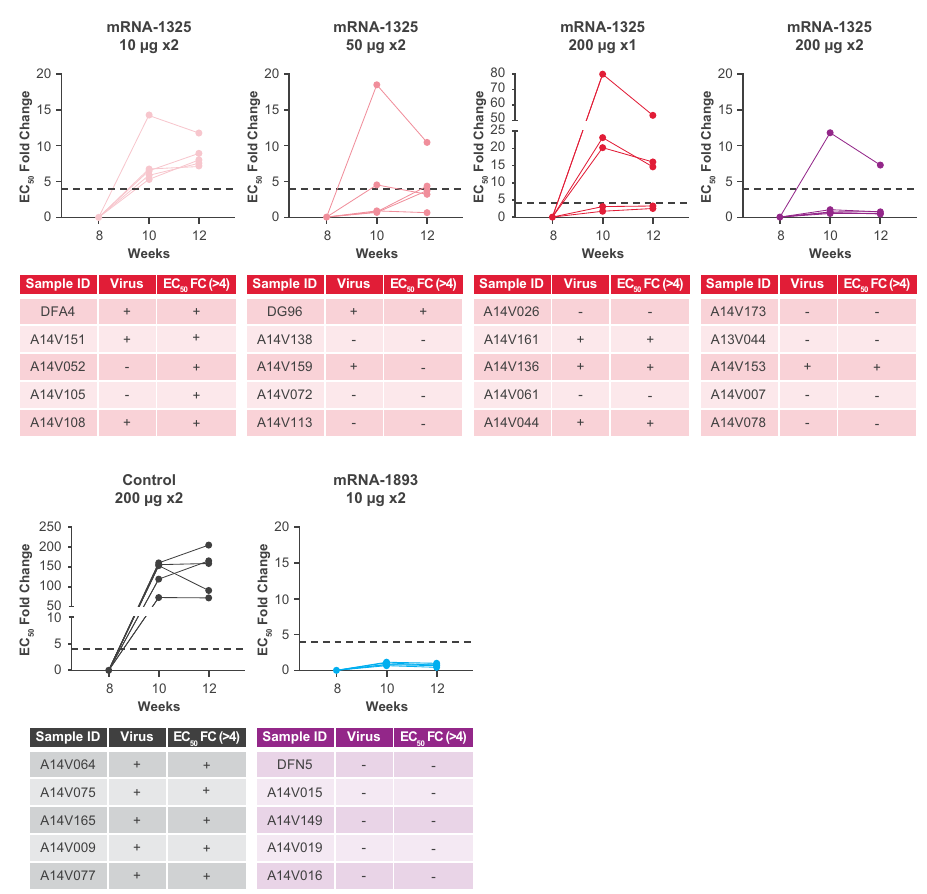
Fig. 5 nAb titers in NHPs immunized with mRNA-1893. Data are plotted as the EC 50 fold change relative to the time of challenge (week 8), which was set to 1. Tables below each graph indicate whether the virus was detected on any day following the challenge and if the EC 50 value had a 4-fold or greater increase following the challenge. n = 5 per group. EC 50 , half-maximal effective concentration; FC, fold change; nAb, neutralizing antibody; NHP, non-human primate; RVP, reporter virus particle; ZIKV, Zika